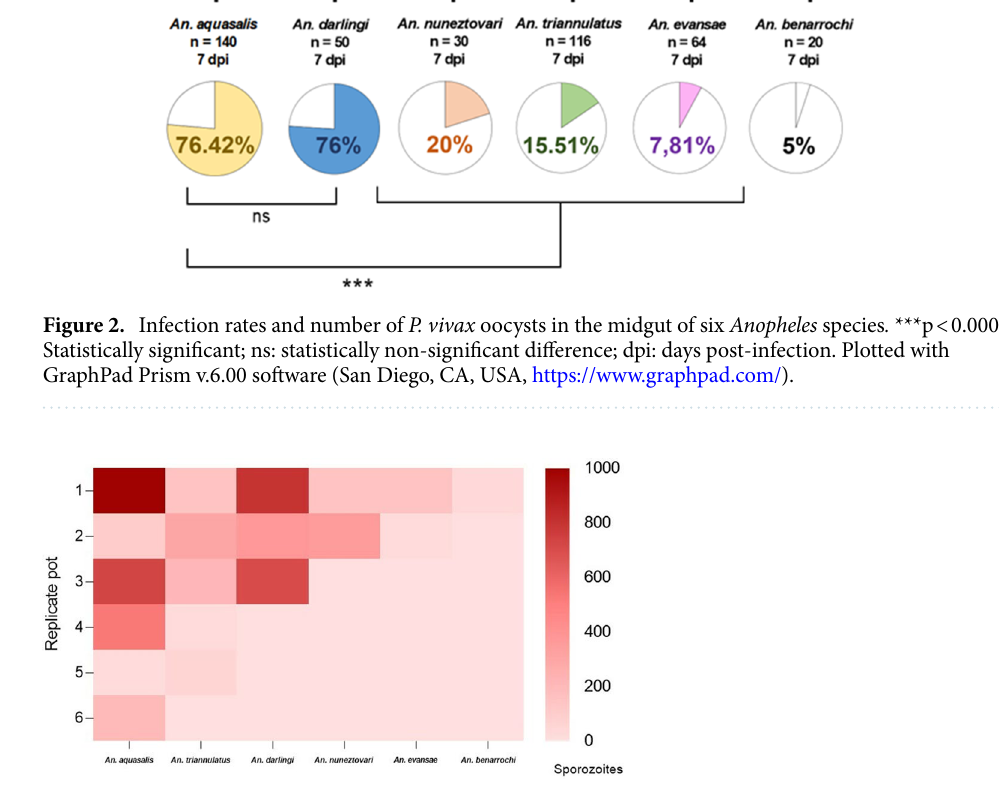
Figure 3. Heat map showing the relative amounts of P. vivax sporozoites in the salivary glands of Anopheles species. Mean number of sporozoites per mosquito. Each row shows the sporozoite quantification per replicate and each column shows the sporozoite number arranged from top to bottom according to species. Plotted with GraphPad Prism v.6.00 software (San Diego, CA, USA, https:// www. graph pad.